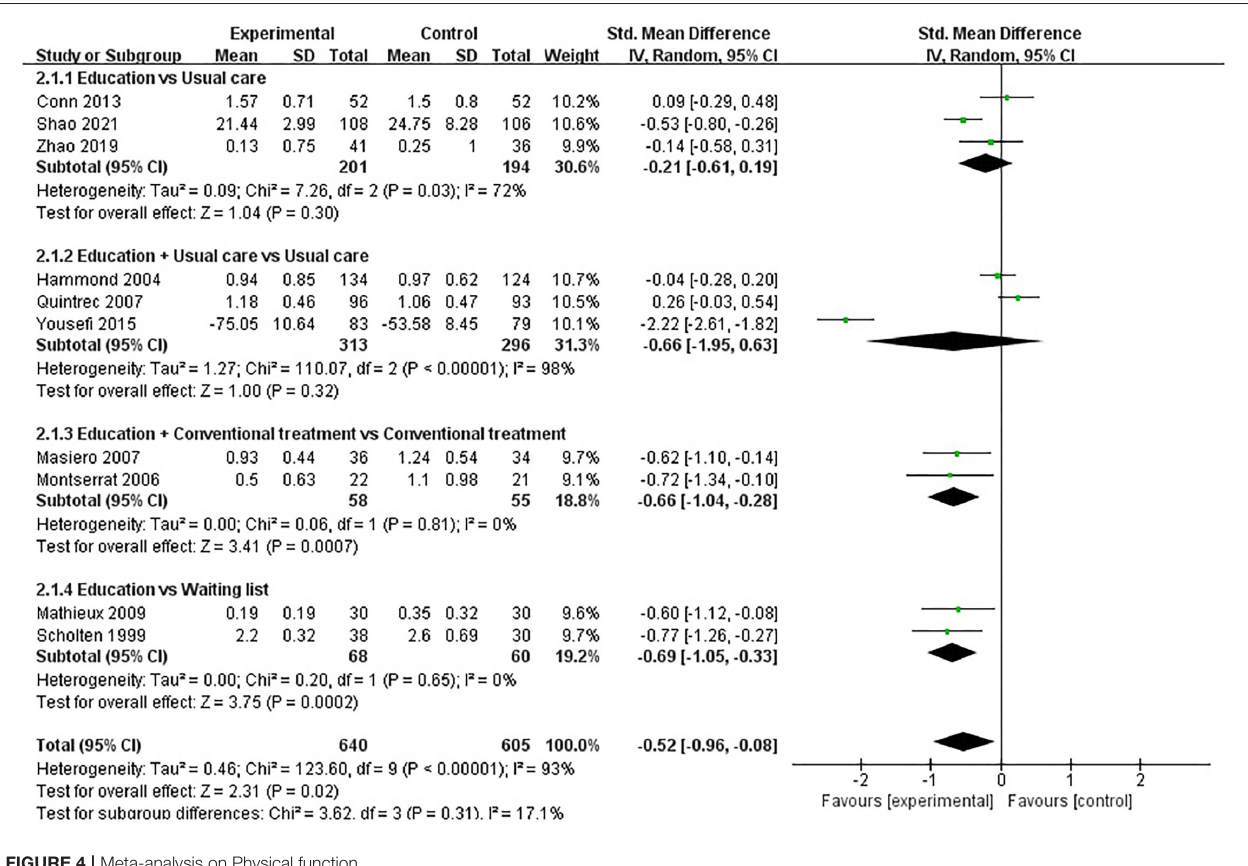
FIGURE 4 | Meta-analysis on Physical function.